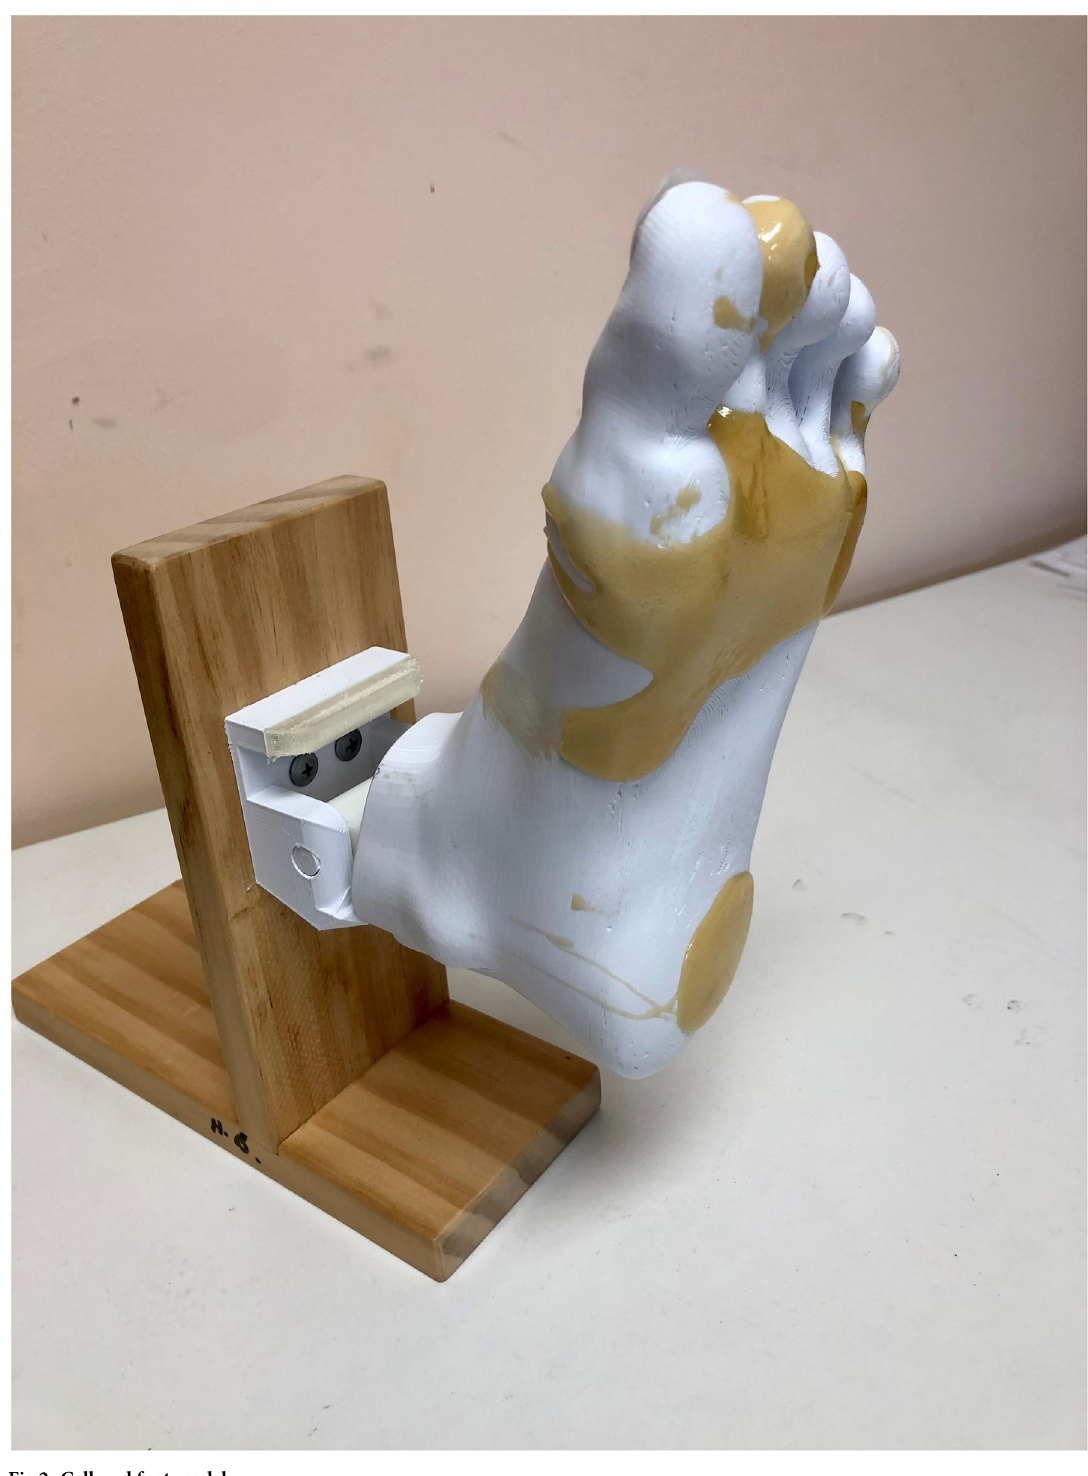
Fig 2. Callused foot